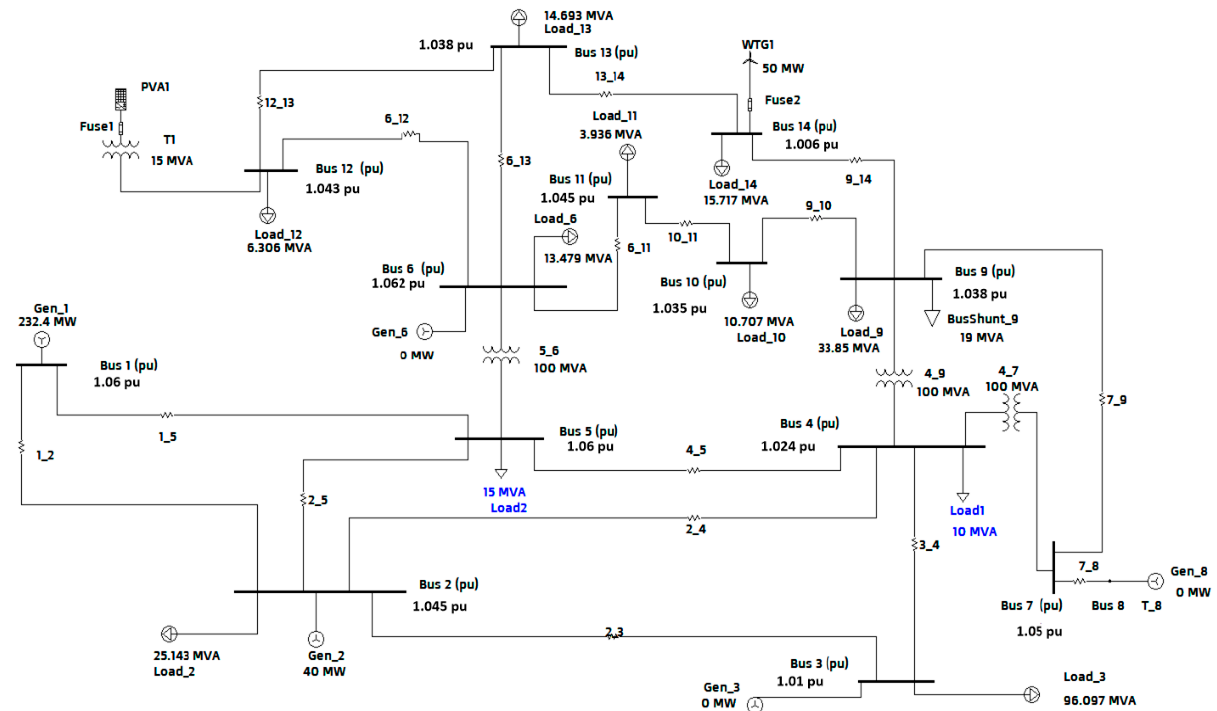
Figure 4. IEEE 14 bus test system (bus voltages in pu after power flow analysis). Table 2. Test system parameters.